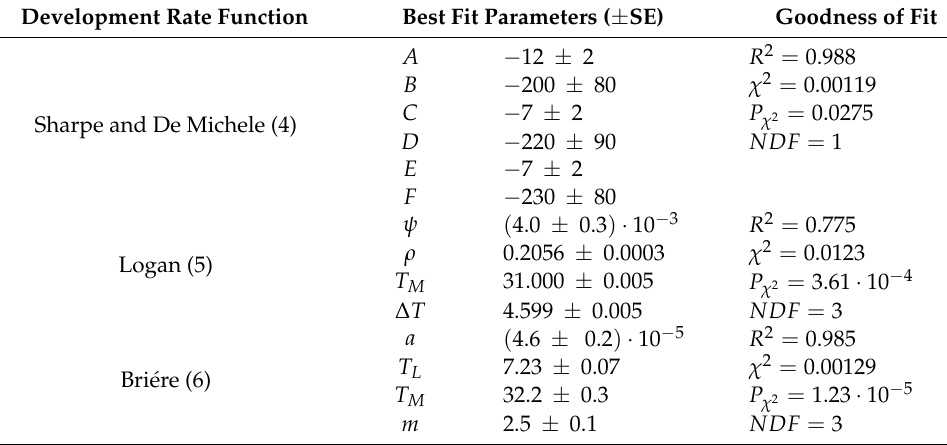
Table 1. Development rate functions (4), (5), and (6) best-fit parameters and their associated standard errors (SE) for the whole egg-adult stage. Parameters were estimated using the dataset published by Wang et al. [35]. The goodness of fit was based on the χ 2 -test and its associated p -value, the coefficient of determination R 2 , and the number of degrees of freedom (NDF). The best fitting functions are plotted in Figure